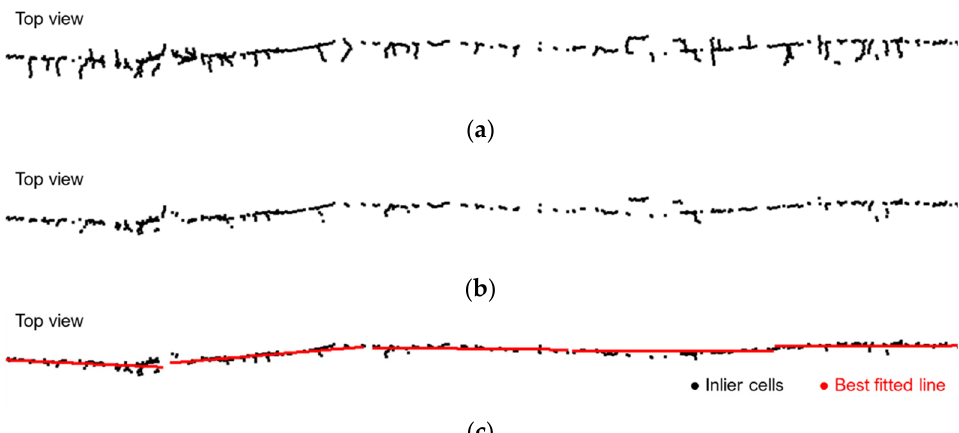
Figure 8. Longitudinal profile extraction showing top view of: ( a ) drainage network, ( b ) drainage network after removing tributaries, and ( c ) streamlines after outlier removal.